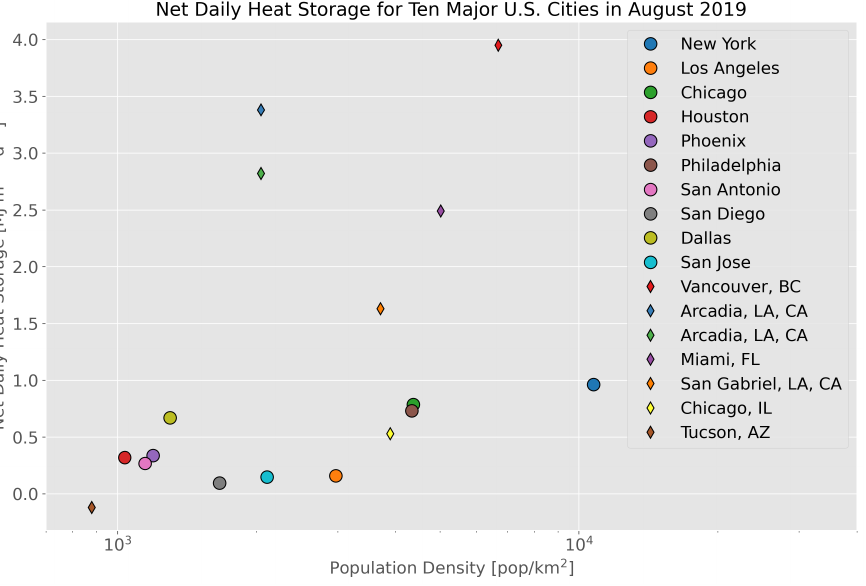
Figure 8. Daily net heat storage compared for different urban areas using the satellite thermal variability scheme (circles) and values taken from the literature